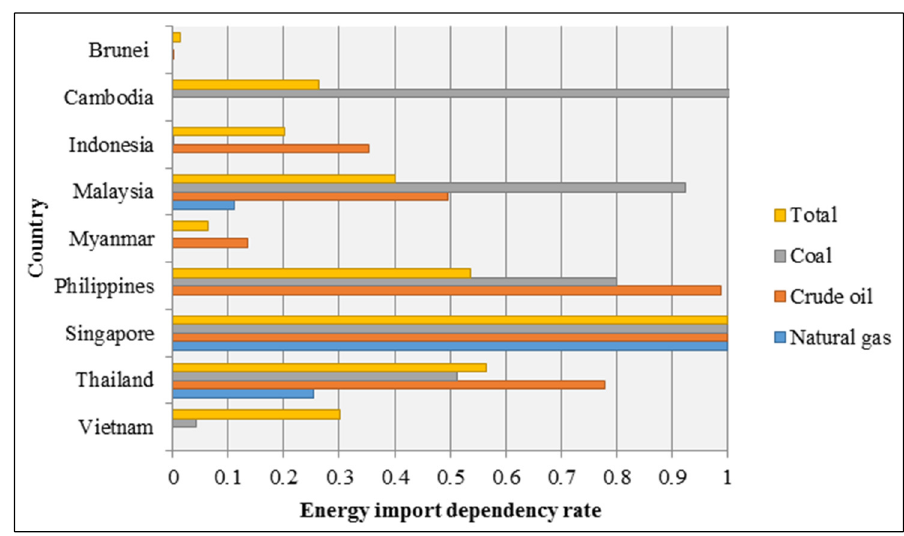
Figure 42. Energy import dependence (by